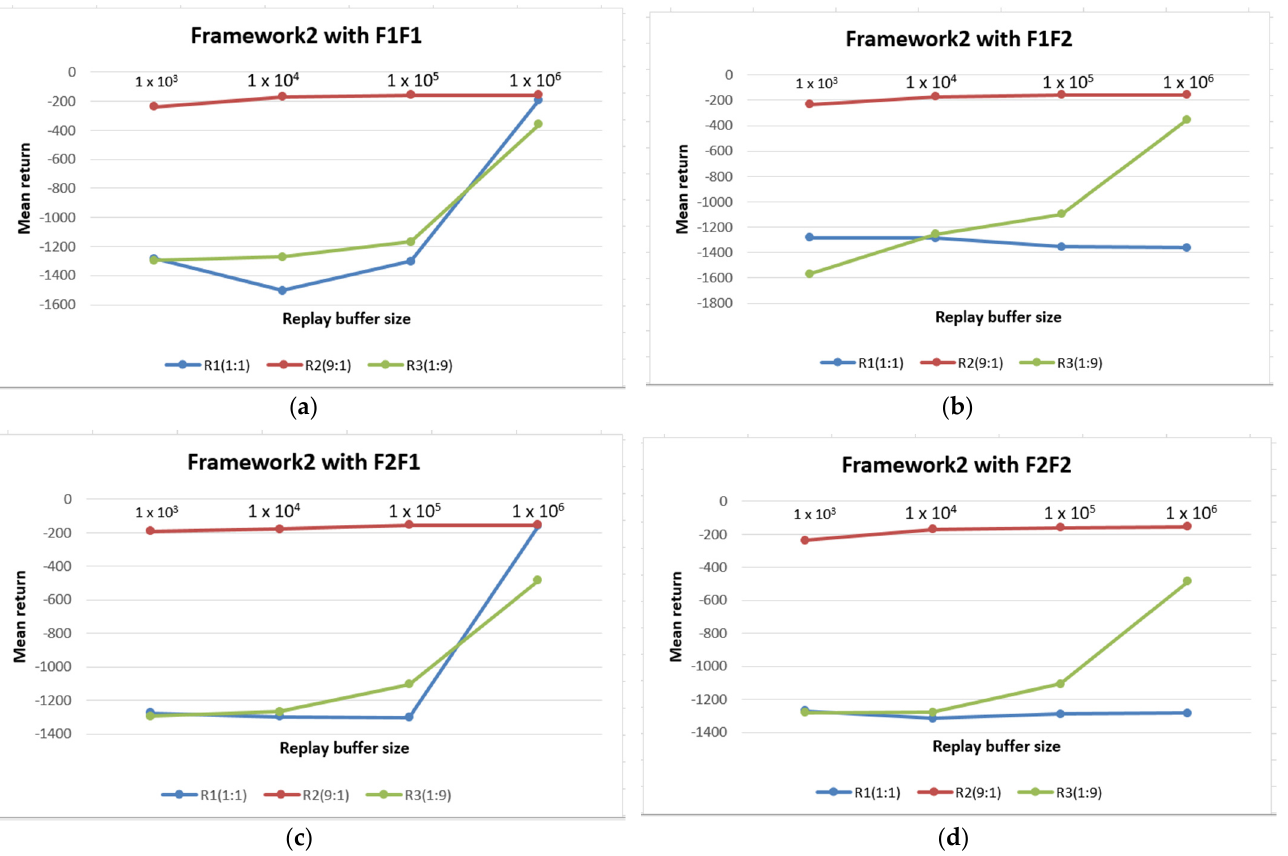
Figure 6. Performance of Framework 2 across multiple buffer sizes, retention strategies, and sampling ratios. ( a ) Framework 2 is evaluated using the FIFO retention strategy for both replay buffers; ( b ) Framework 2 is evaluated using FIFO for the first replay buffer and enhanced FIFO for the second replay buffer; ( c ) Framework 2 is evaluated using enhanced FIFO and FIFO for the first and second replay buffers, respectively; ( d ) Framework 2 is evaluated using enhanced FIFO for both replay buffers. Table 5. The average performance of the frameworks across the buffer sizes with a sampling ratio of 9:1.